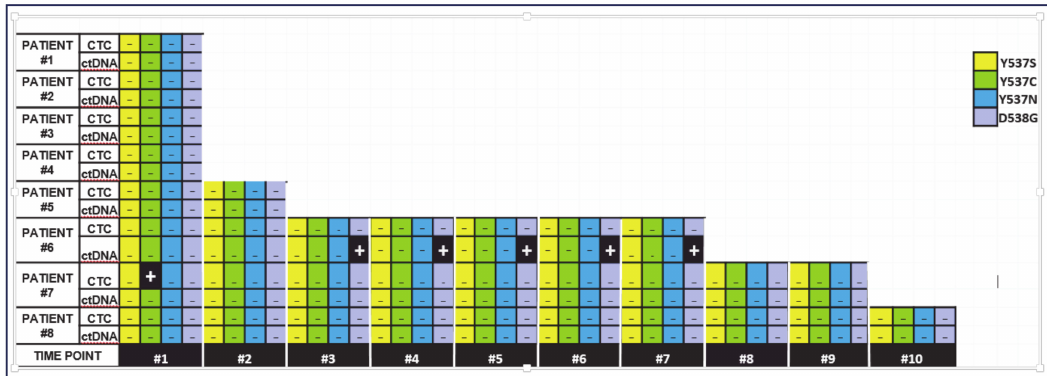
Figure 7. ESR1 NAPA assay application in liquid biopsy